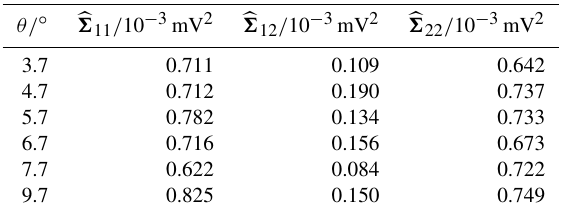
Figure 15. As Fig. 9 but for the GLS approach applied to the data with indices m LOW to m HGH and assuming a plume is contained in a window defined by indices m s and m e . The vertical lines show the endpoints of the window that is assumed to contain the plume.